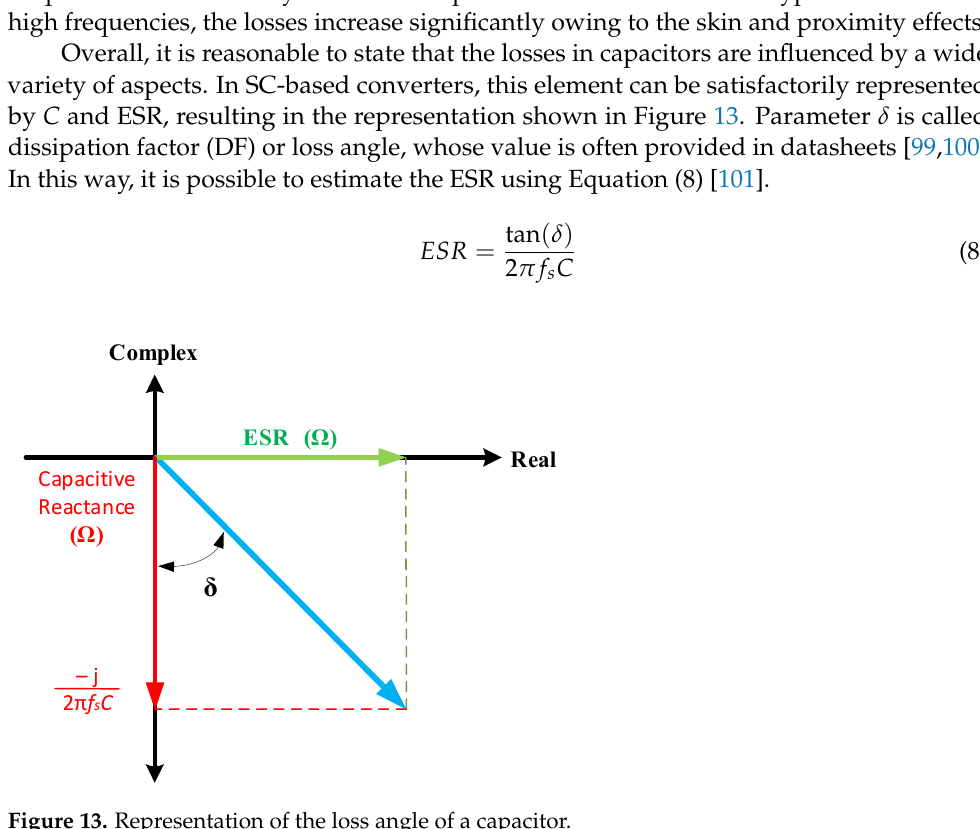
Figure 12. Equivalent circuit of a capacitor.